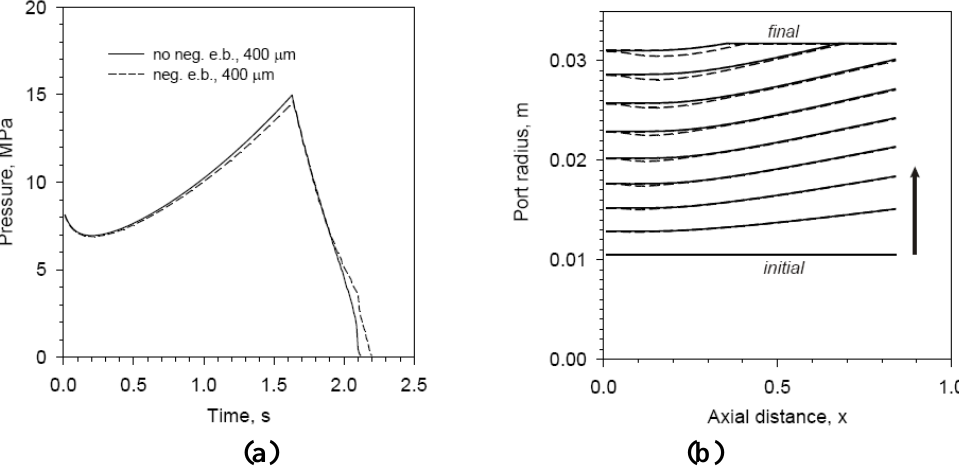
Figure 4. (a) Predicted head-end pressure profile for reference cylindrical-grain SRM, with and without a negative erosive burning model component, at reference propellant surface roughness; (b) Predicted port grain radius profile from head-end (left) to port exit (right), with (dashed curves) and without a negative erosive burning model component (solid curves), at 0.25-sec increments (curves move upward as the grain burns back, from the initial port radius of 1.05 cm, towards the upper insulation/wall boundary at a radius of 3.175